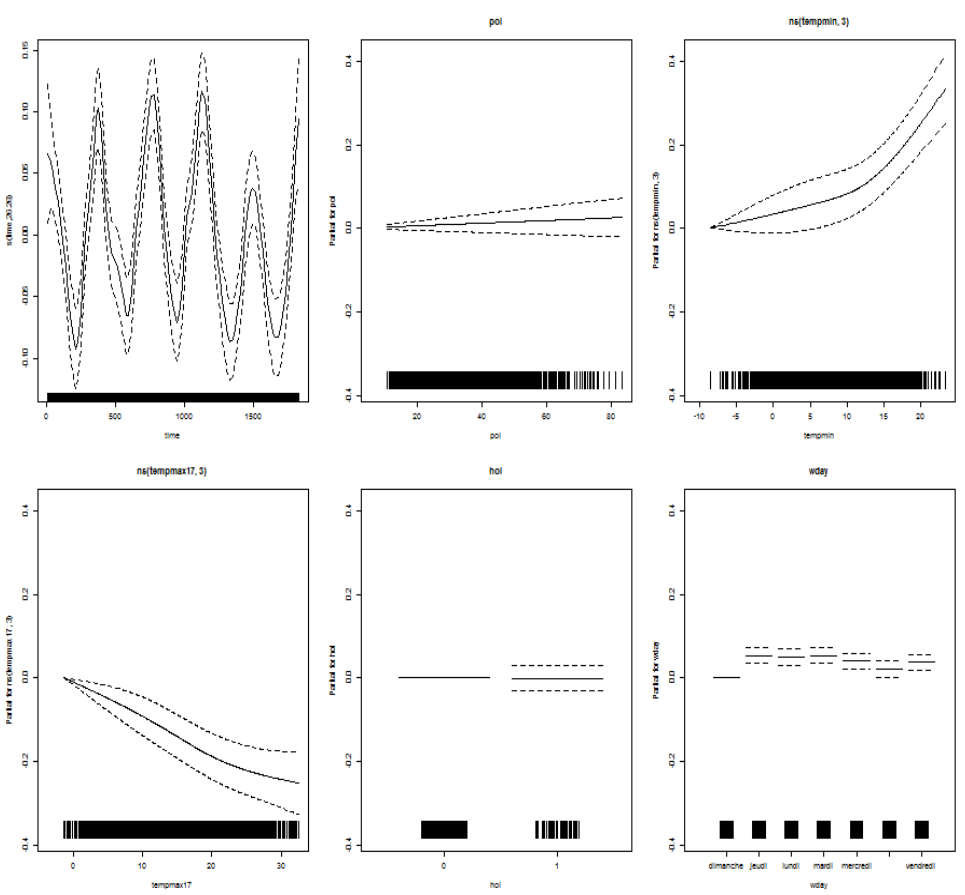
Figure A1. Assessment of the modeling assumptions for Paris.